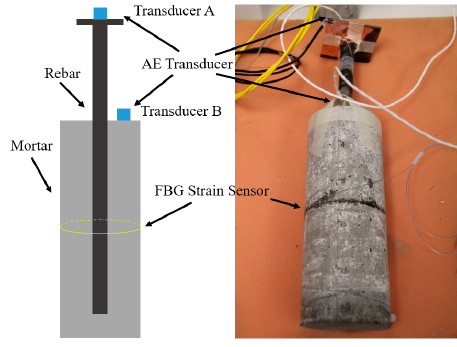
Figure 2. Reinforced mortar specimen and sensor installation.